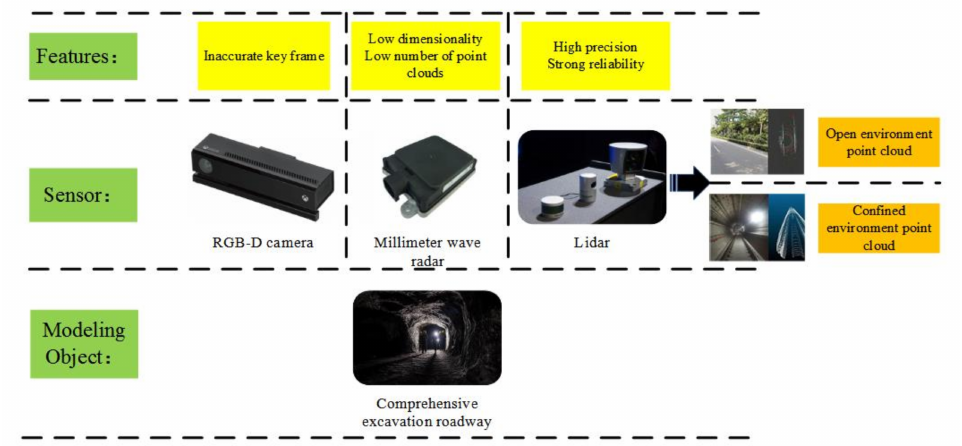
Figure 2. Comparison of point cloud acquisition methods.